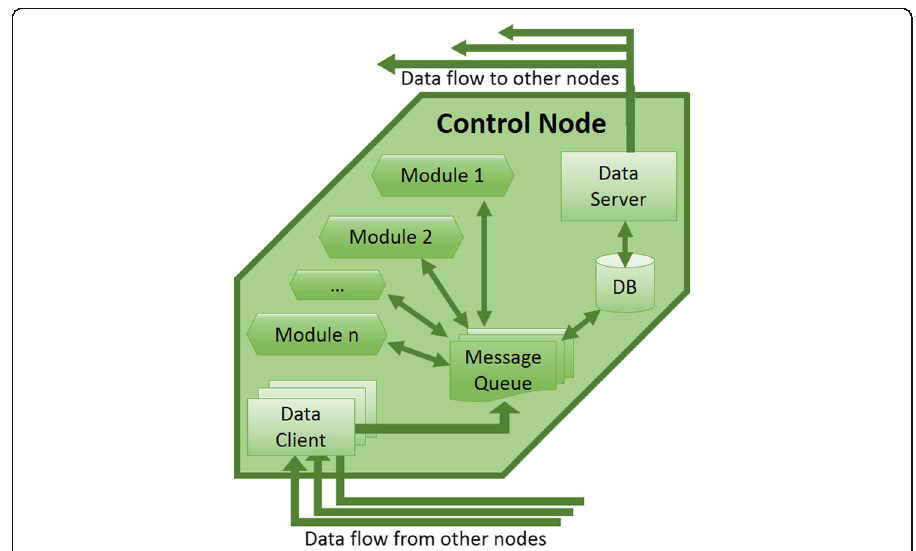
Fig. 2 Structure of a control node. Messages from the other nodes in the micro grid are delivered into the message queue to be processed by the control node ’ s modules. Changes in a node ’ s database values are then communicated as messages to connected control